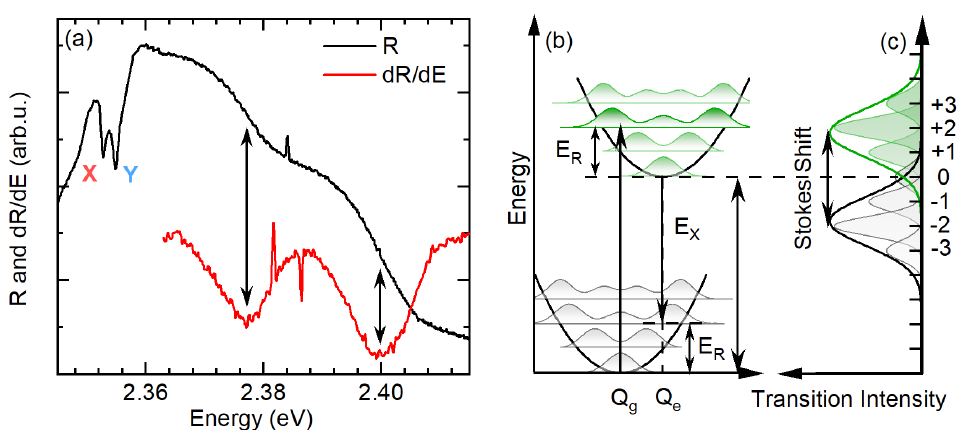
Figure 2. ( a ) Broad spectral range reflectance spectrum of (PEA) 2 PbI 4 (black line) and its derivative (red line). The minima in derivative correspond to transition energies. ( b ) Schematic showing the Franck–Condon model (configurational coordinate diagram). The lower and upper parabolas represent the harmonic potential for the lattice in the ground and excited state. The shaded area corresponds to the spatial probability distribution of the harmonic oscillator. The arrows show examples of the transition from the ground (excited) vibrational level 0 to the vibration level 2 of the excited (ground) state. Such a transition results in the emission of two phonons. ( c ) Schematic of absorption (green) and emission (grey) spectra of exciton coupled to lattice vibration. The envelope lines represent the merged responses of phonon replicas involving different numbers of phonons also known as phonon